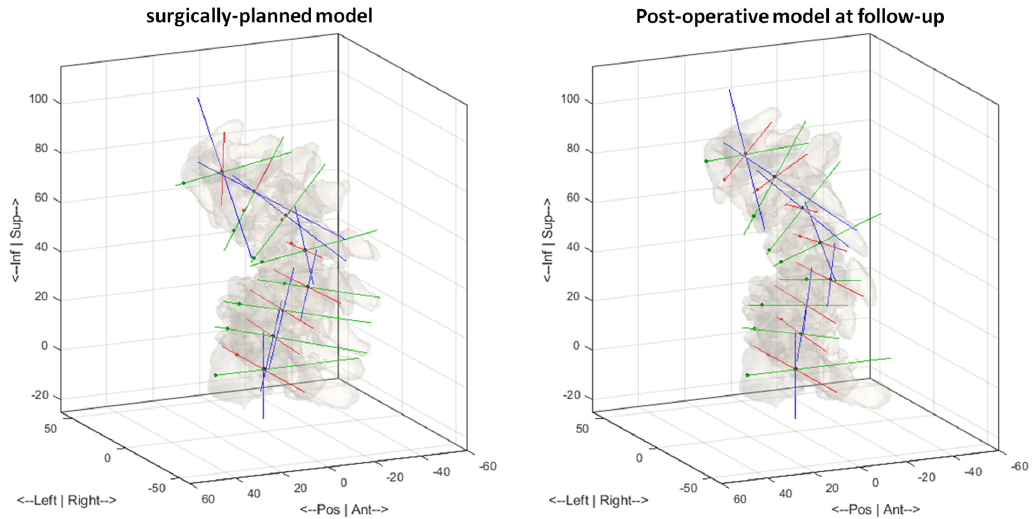
Figure 10. Anatomical reference frames (anterior-posterior, medial-lateral, and proximal-distal axis in red, green, and blue, respectively) defined on each vertebra for inter-vertebra rotational assessment in the PLA-VIR ( left ) and POS-VIR ( right ). Table 1. Pre ‐ (PRE) and post ‐ operative (POS) relative orientations of the cervical vertebrae calcu ‐ lated with respect to T1 ‐ based anatomical reference frame in PLA ‐ VIR and POS ‐ VIR.